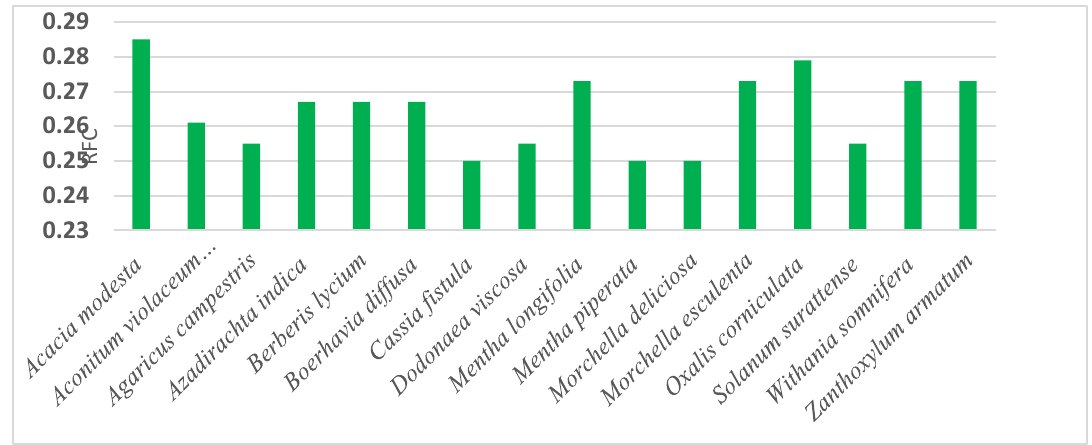
Figure 3. Medicinal plants and fungi with Highest Relative Frequency Citation.